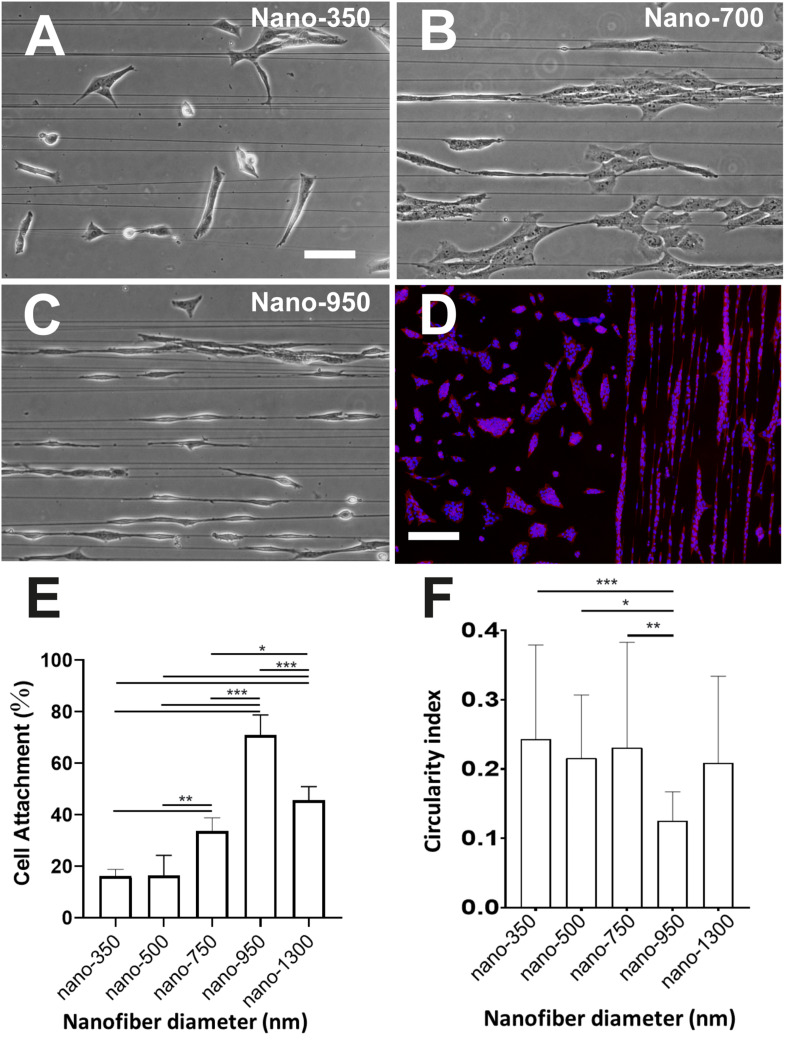
Cytomorphometric analysis of TEG3 over different diameter PLA nanofibers. Cells adhered onto fibers on coverslips with associated laminin of an averaged fiber diameter of (A) 350 nm, (B) 700 nm, and (C) 950 nm; (D) DAPI/phalloidin fluorescent image of cells adhered to a surface with (right) and without (left) 950 nm-fibers over an inhibiting coating of CSPG; (E) histogram showing the percentage of attachment of the cells with the different diameters of PLA nanofibers (biomaterial; ***p-value < 0.0001; **p-values 0,0017 and 0.0020; *p-value 0.0411; and N = 5); and (F) their shape circularity index of cells attached to the different fibers assessed in this work (***p-value < 0.0002; **p-value 0.0019; *p-value 0.0170; and N > 25). Scale bars (A) (same for B,C) – 50 μm; and (D) – 300 μm.